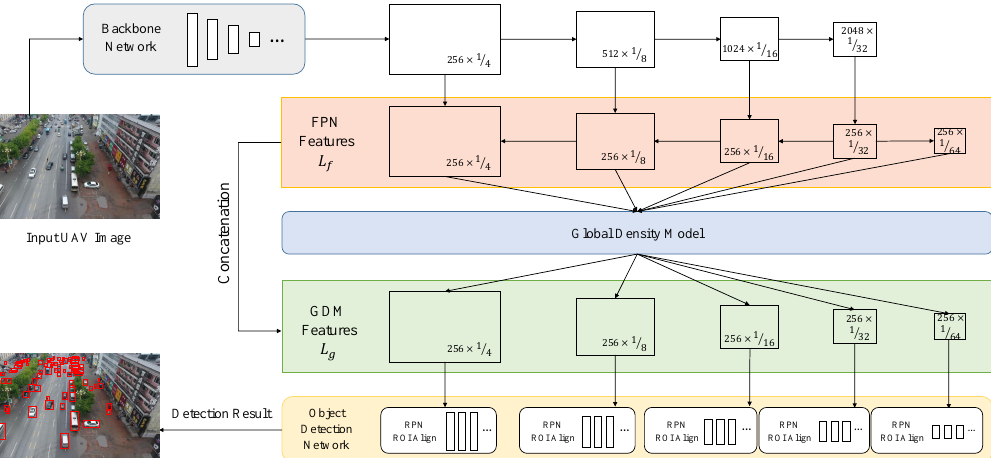
Figure 1. An overview of the proposed global density fused (GDF)-Net architecture. The GDF-Net consists of the Backbone Network, Global Density Model, and Object Detection Network, where the Backbone Network extracts pyramid features with typical networks, the Global Density Model integrates object distribution information into pyramid features, and the Object Detection Network locates and categorizes objects from UAV